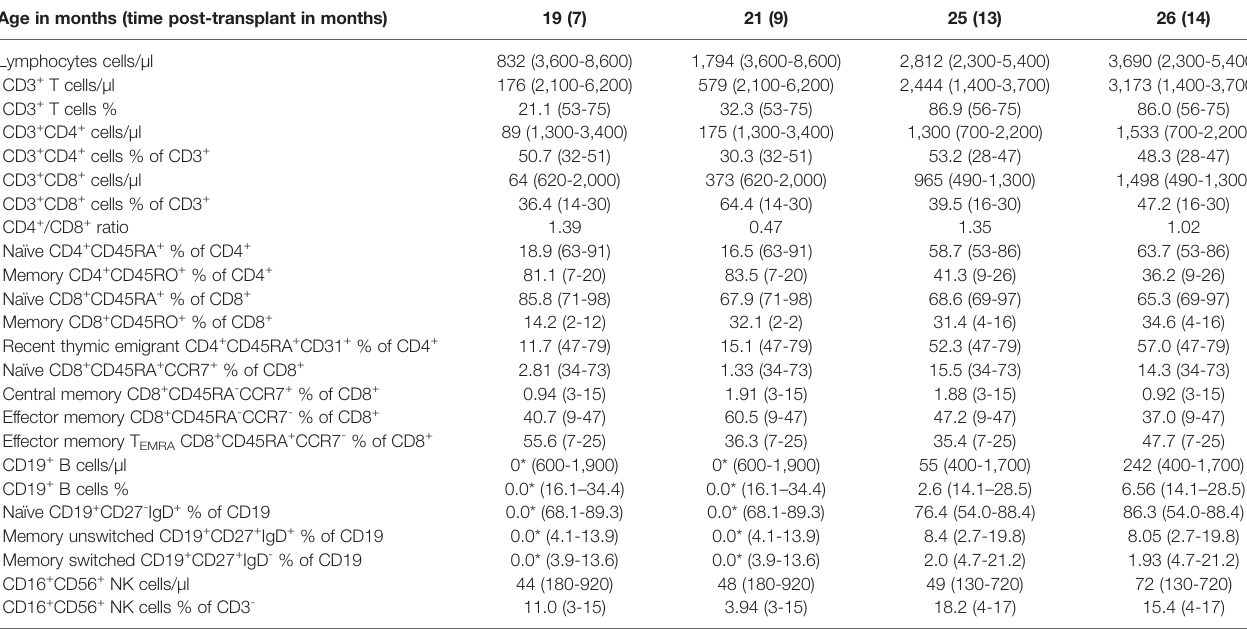
TABLE 2 | Lymphocyte immunophenotype